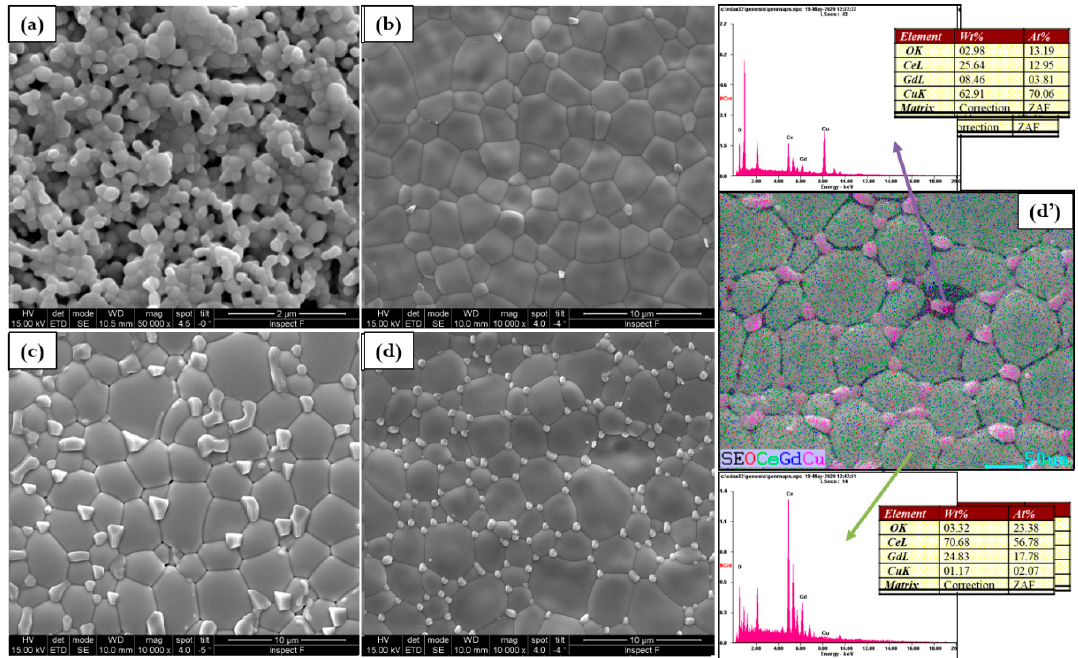
Figure 6. Microstructure evolution for ( a ) GDC, ( b ) 0.5 Cu, ( c ) 1 Cu, ( d ) 2 Cu, and ( d’ ) EDX mapping of 2 Cu sintered at 1200 °C. 2 Cu sintered at 1200 ◦